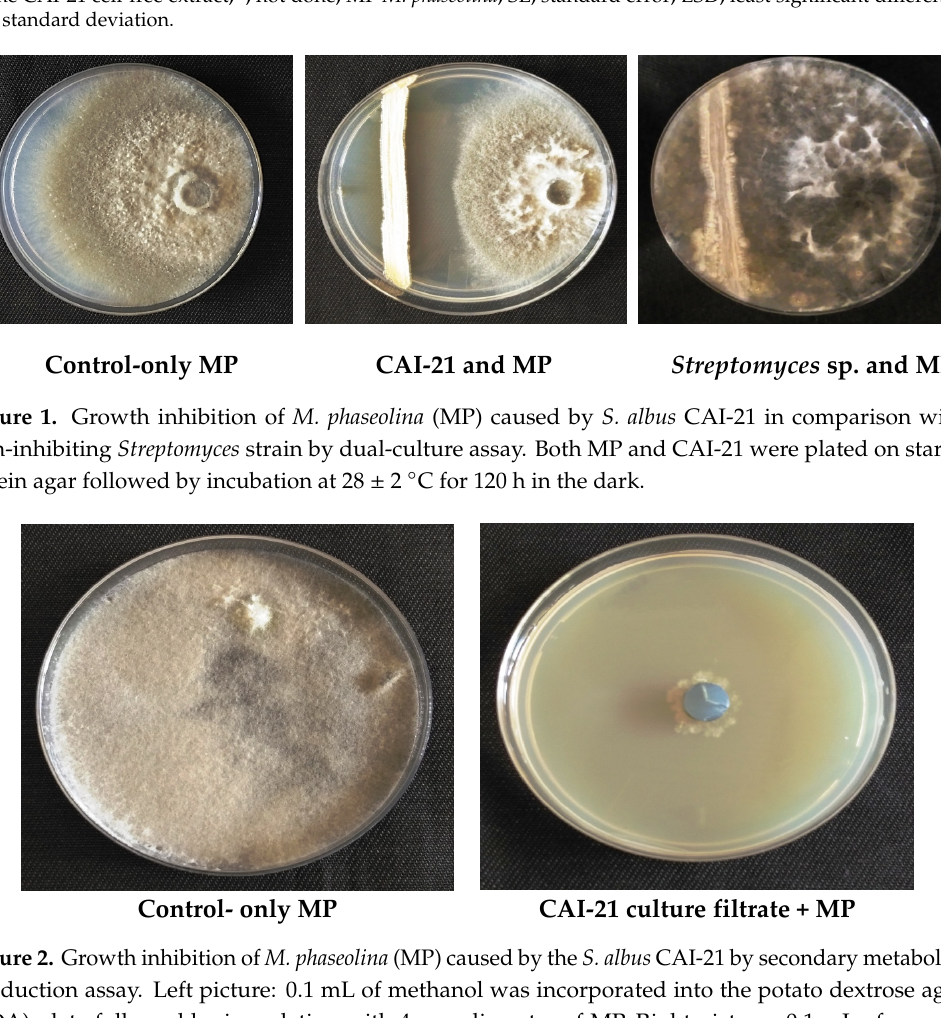
fraction of the CAI-21 cell-free extract; -, not done; MP M. phaseolina ; SE, standard error; LSD, least significant difference; SD, standard deviation.